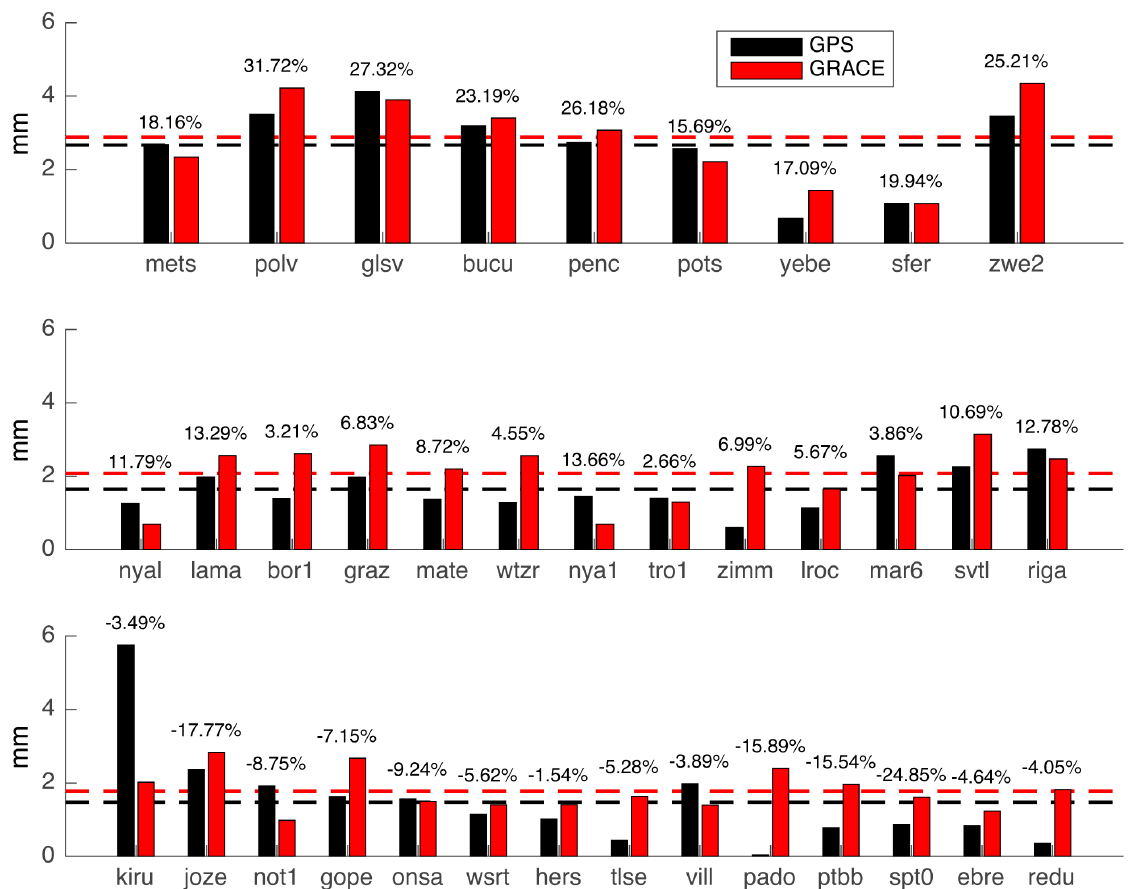
Figure 7. Relationship between WRMS reductions and loading signal amplitudes for three selected groups of the 36 sites. The three panels represent WRMS reductions are: (a) larger than 15%; (b) between 0 and 15%; (c) smaller than 0. The height of bar represents annual am- plitude of GPS/GRACE vertical displacements at the site. The dash line represents the mean GPS/GRACE amplitude of the class. WRMS reduction of each site is marked above the